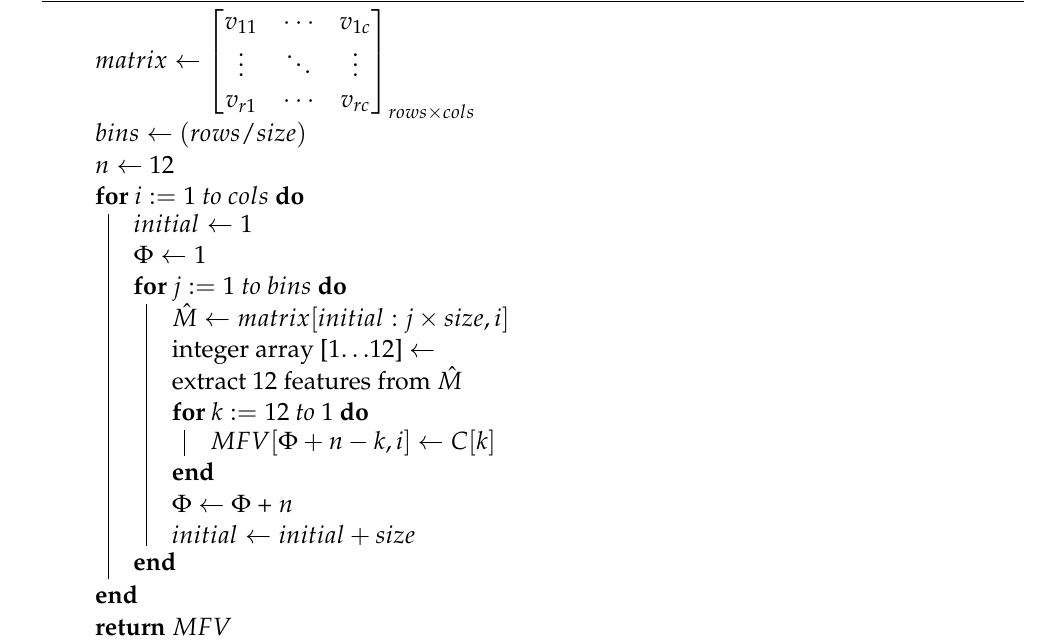
Algorithm 1: Constructing the Master Feature Vector for